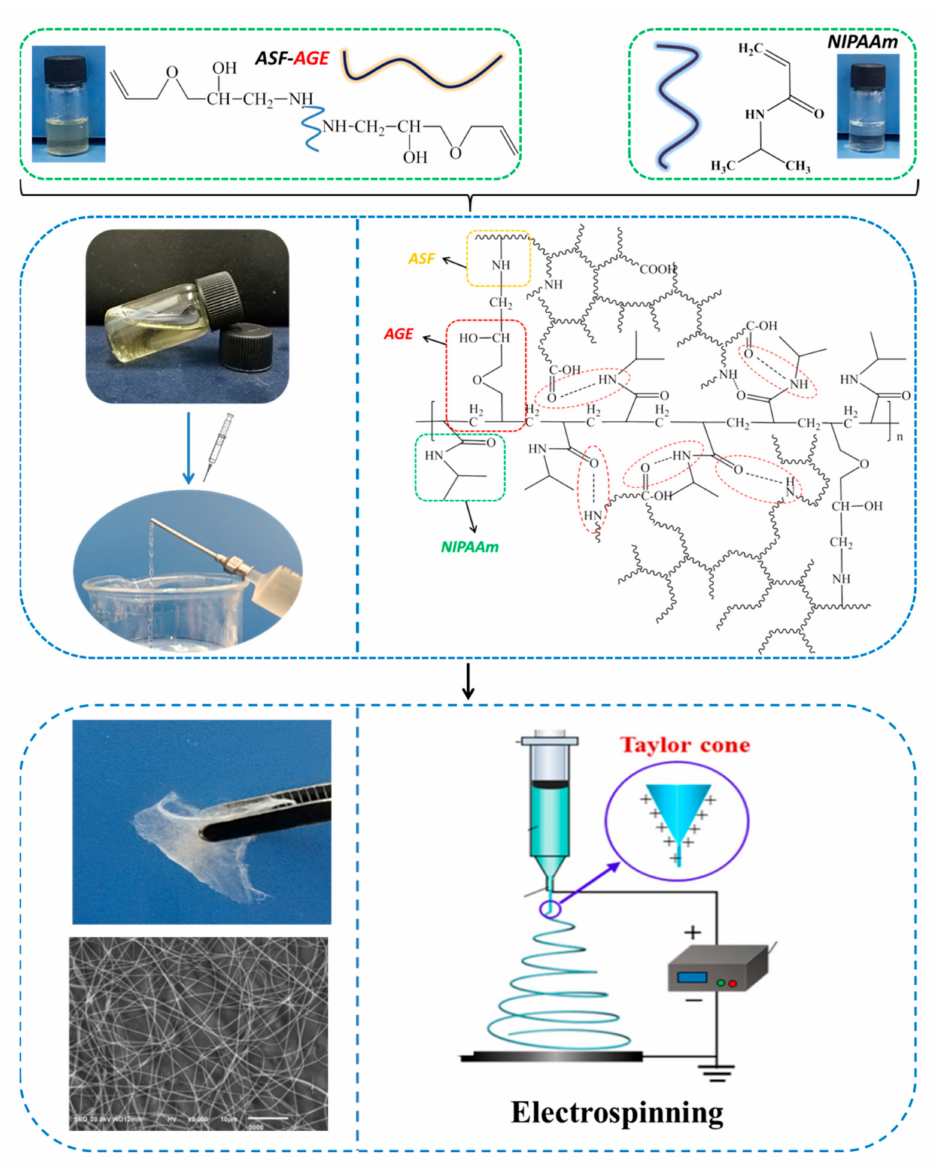
Figure 4. Preparation of p (ASF-AGE-NIPAAm) hydrogel